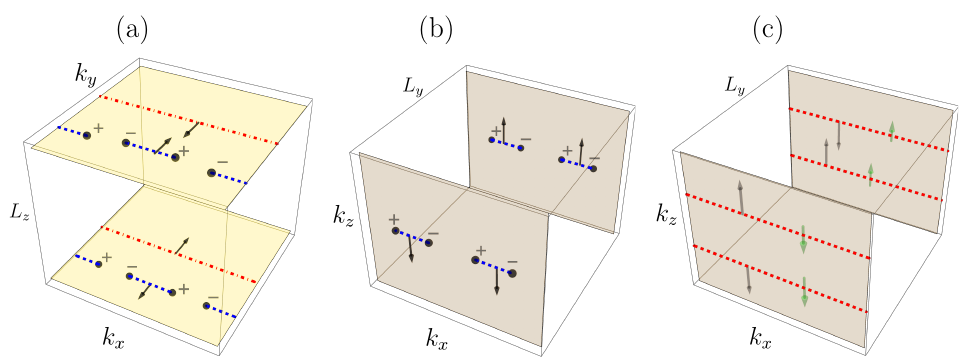
Figure 5: The zero-energy Fermi arc surface states shown in Fig. 3 in the W2 (cid:48) phase, are depicted here through the cartoon figures (a) and (b), in mixed real and momen- tum space representation. (a) In the k - k surface BZ, there are two types of surface x y states: type (i) surface states (shown in blue), which are the standard Fermi arcs, end at the Weyl point projections ; type (ii) surface states (shown in red) live across ) , of the particles occupying the type (i) the surface BZ. The velocity v = ∇ E ( k , k x y surface states are along the positive / negative y -direction on the top / bottom surface. For type (ii) surface states, the direction of the velocity gets reversed. So type (i) ) = 1, and type (ii) surface states are counter propagating. The Chern number C ( k x if the constant k plane cuts only the type (ii) surface states, else it is zero. (b) In x the k - k surface BZ, there are only type (i) Fermi arc surface states which end at the x z Weyl point projections. Here we note that the W2 (cid:48) phases which share a boundary with the I (cid:48) phase (see Fig. 1c) have two types of surface states which co-exist on the k - k surface BZ. (c) This cartoon figure shows the zero-energy surface states in the x z I (cid:48) phase, in mixed real and momentum space representation. In the I (cid:48) phase, there exists localized surface states only on the k - k surface BZ. On both the open crystal x z surfaces y = 0 and y = L , there are two counter propagating surface states with y ) = 0, green arrows indicating their spin polarization. Here, the Chern number C ( k x for all k x